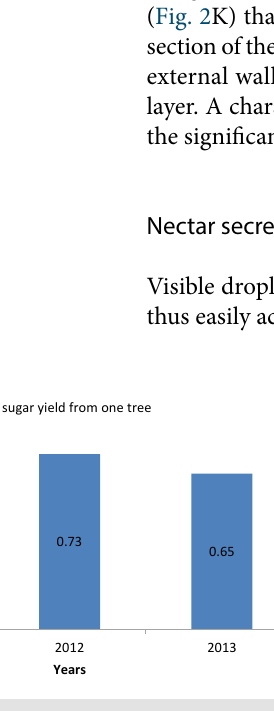
Fig. 3 Sugars yield of Acer pseudoplatanus in the